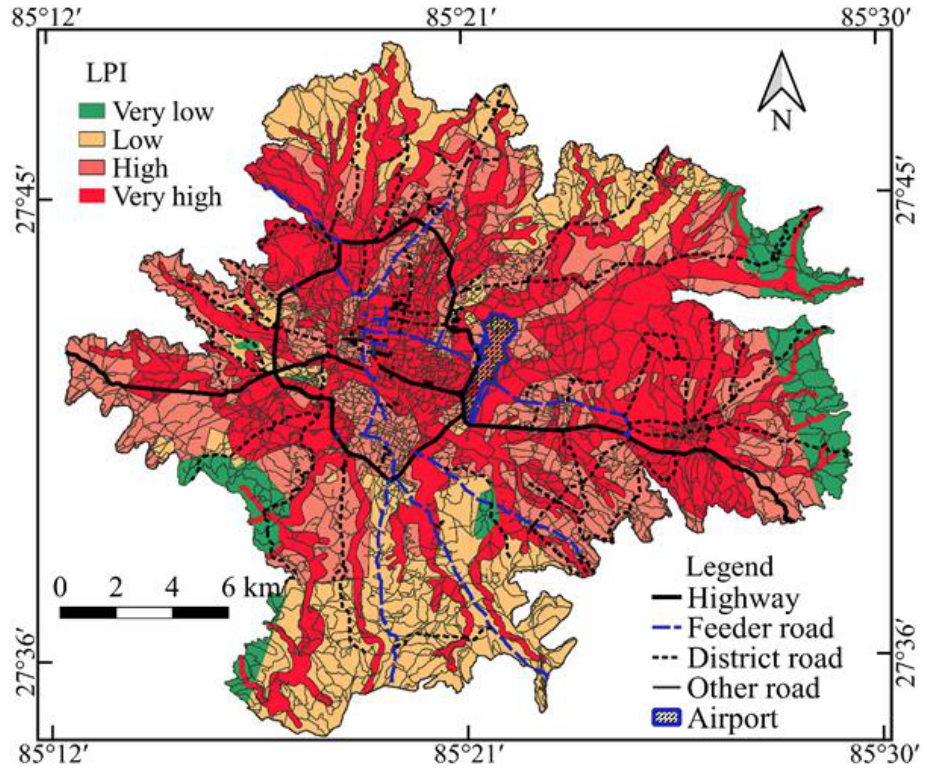
Figure 12. Liquefaction susceptibility map with road network and airport of Kathmandu Valley. Table 3. Liquefaction susceptibility of the road network in Kathmandu Valley.